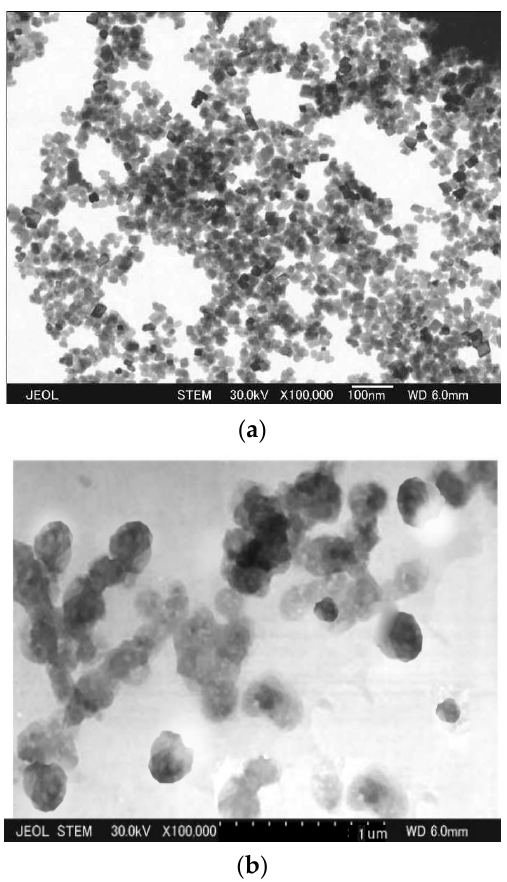
Figure 6. TEM test result. ( a ) NCC suspension; ( b ) PAASM-CaCO 3 suspension.